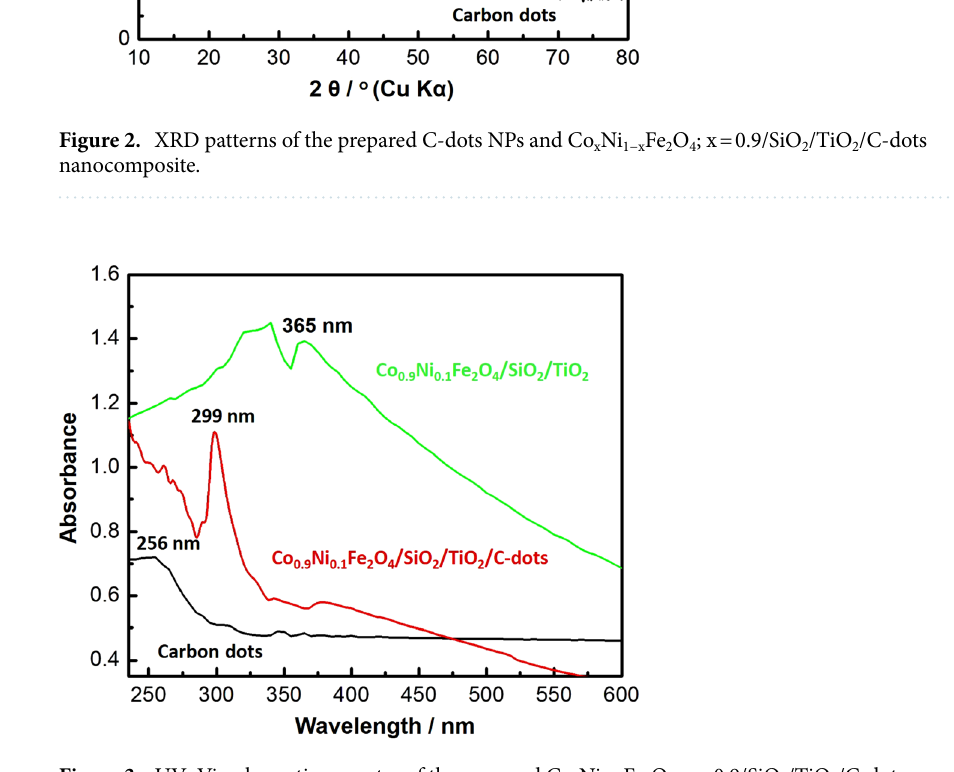
Figure 3. UV–Vis. absorption spectra of the prepared Co x Ni 1−x Fe 2 O 4 ; x = 0.9/SiO 2 /TiO 2 /C-dots nanocomposite, bare C-dots and